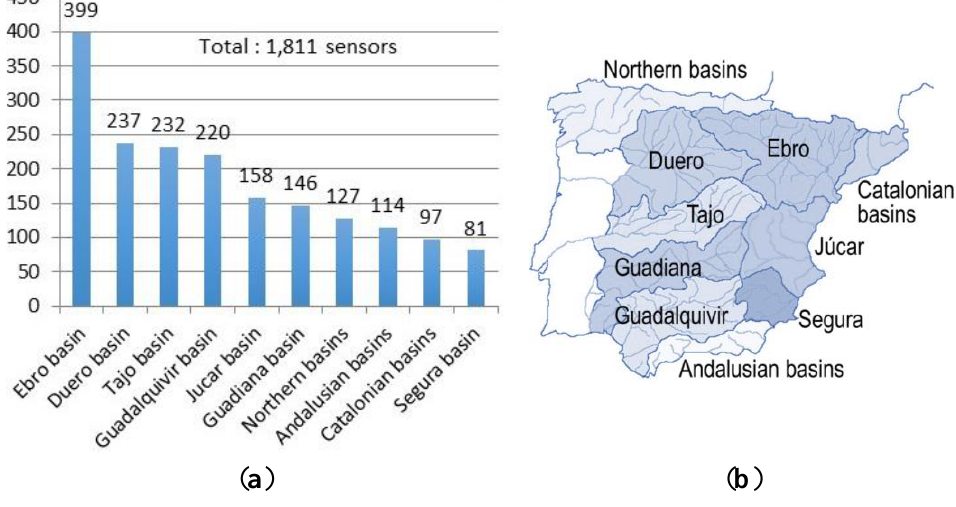
Figure 5. Number of sensors in the evaluation dataset for each geographic area: ( a ) number of sensors; ( b ) geographic